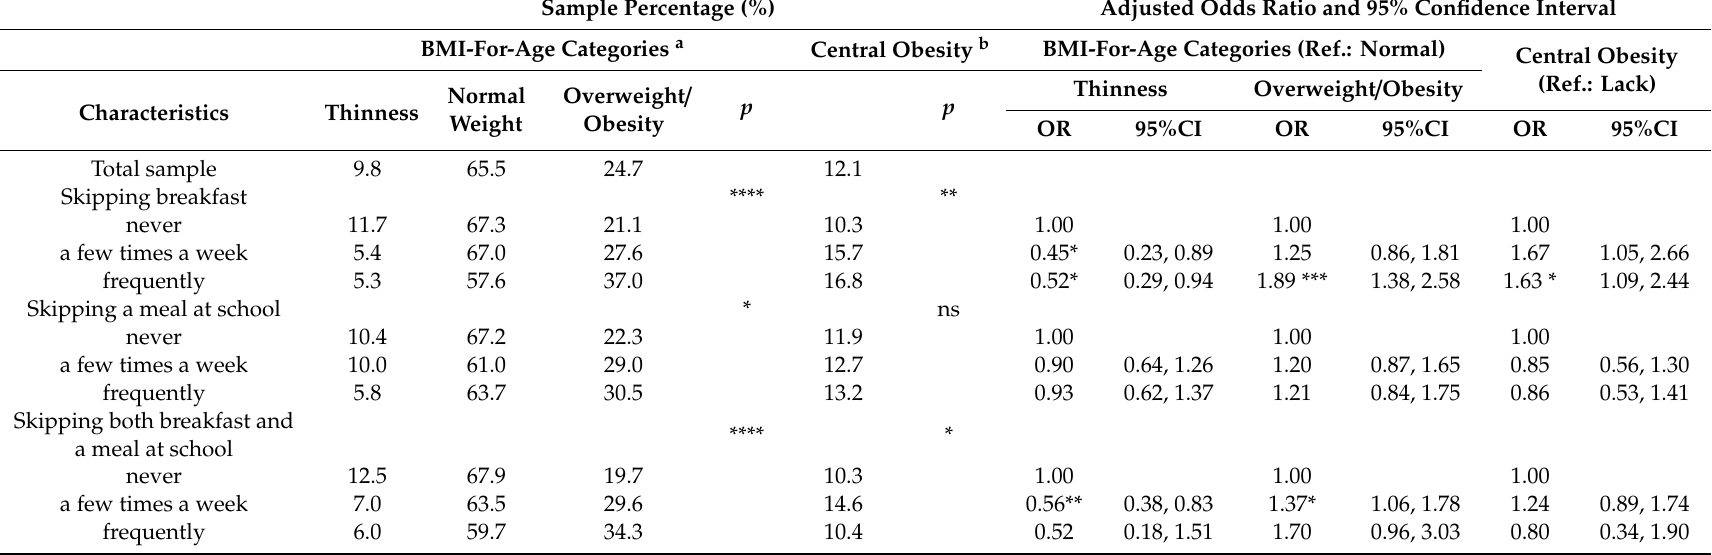
Table 5. Distribution of subjects and the association of skipping breakfast and / or a meal at school with adiposity markers in teenagers. (Adjusted odds ratios (ORs) and 95% confidence intervals (95%CI); multivariate